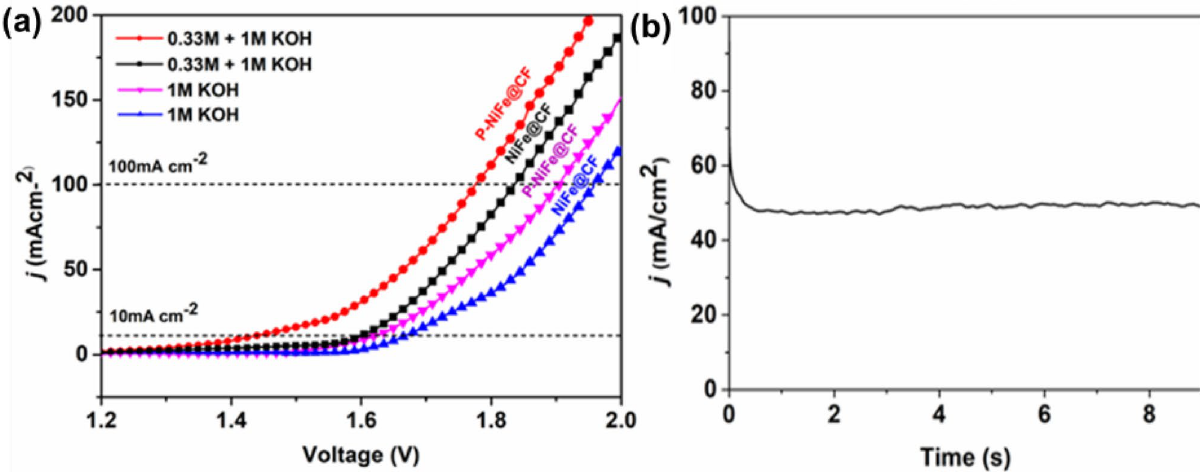
Figure 5. ( a ) Polarization curve of NiFe@CF and P-NiFe@CF in 1 M KOH with urea and without urea, and ( b ) a stability test in 1 M KOH and 0.33 M urea solution using P-NiFe@CF as anode and cathode at an applied potential corresponding to a current of 50 mA cm −2